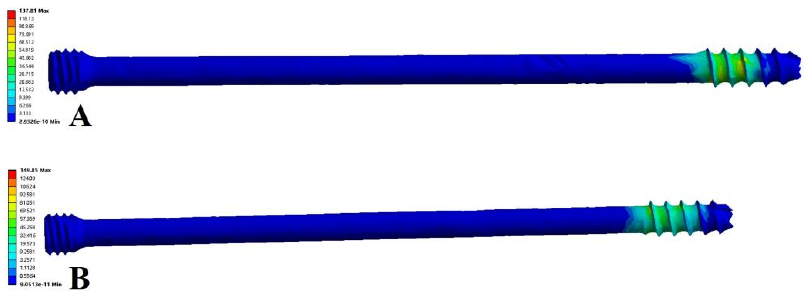
Figure 7. Von Mises stress distribution of implant fixed with anterior hollow screw. ( A ) Standing position. ( B ) Sitting position. Table 4. The maximum stresses (MS) of different finite element model after loading the pelvis.